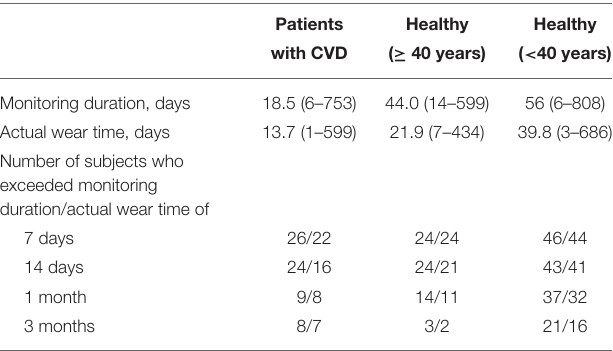
TABLE 2 | Monitoring characteristics in three